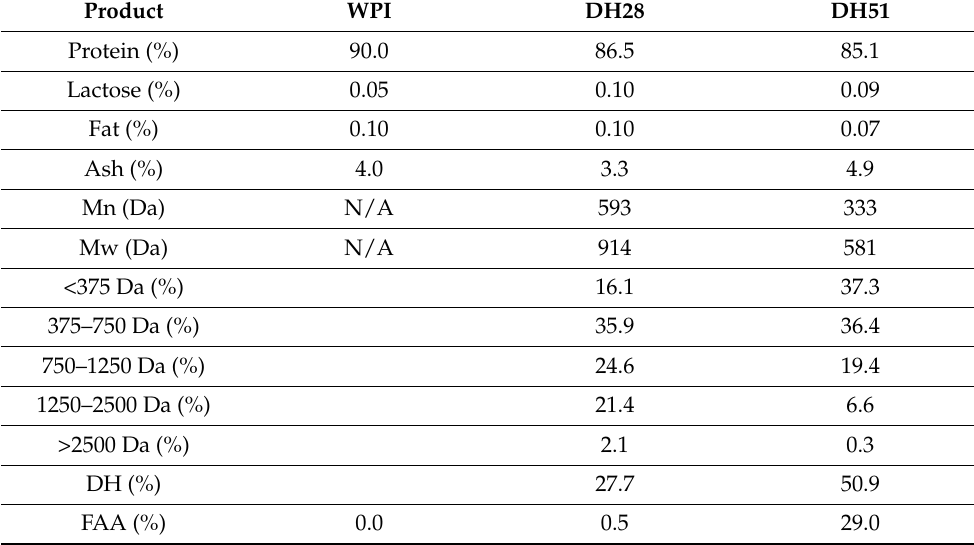
Table 3. Composition of